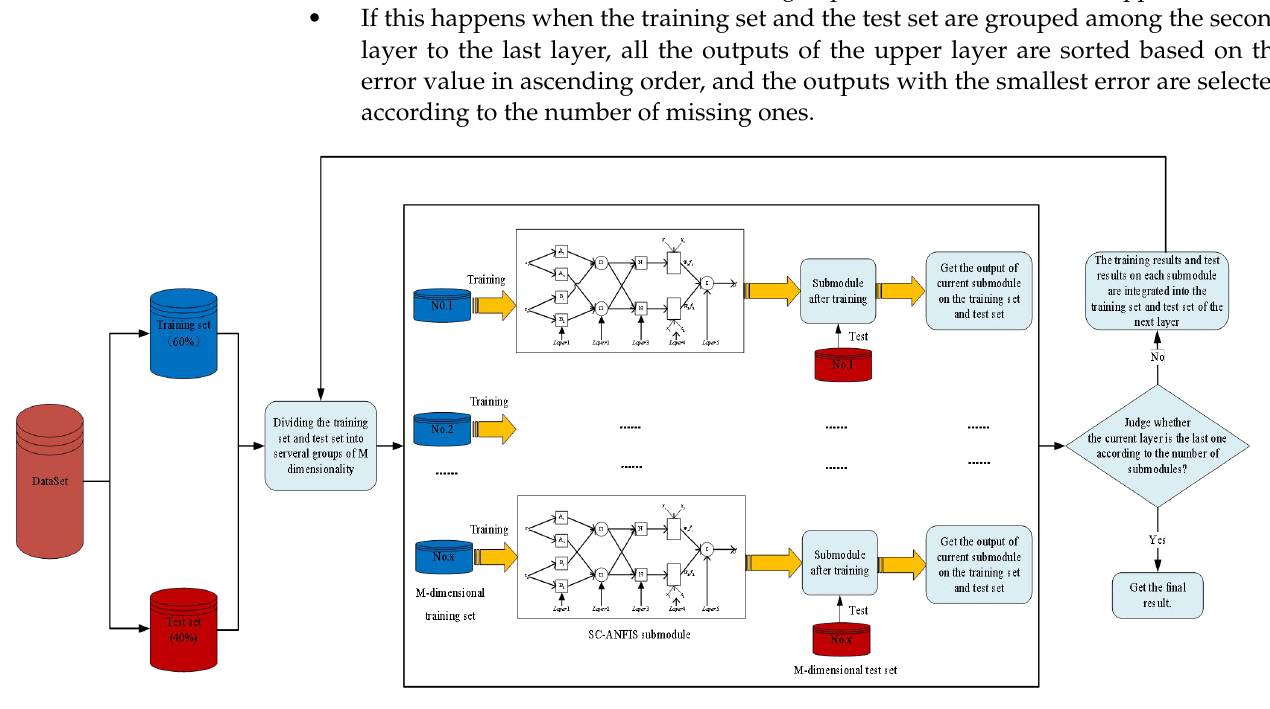
Figure 2. The flowchart of